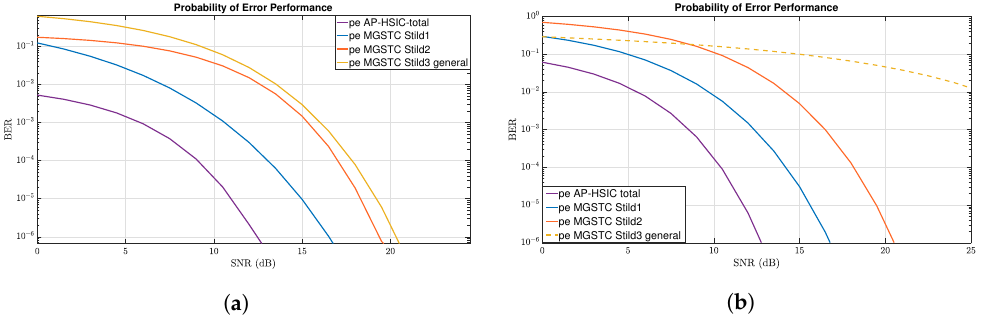
Figure 4. BER vs. SNR of MGSTC and AP-HSIC. ( a ) Comparison under QPSK modulation in the presence of high-level AWGN. ( b ) Comparison under 8-PSK modulation in the presence of high-level